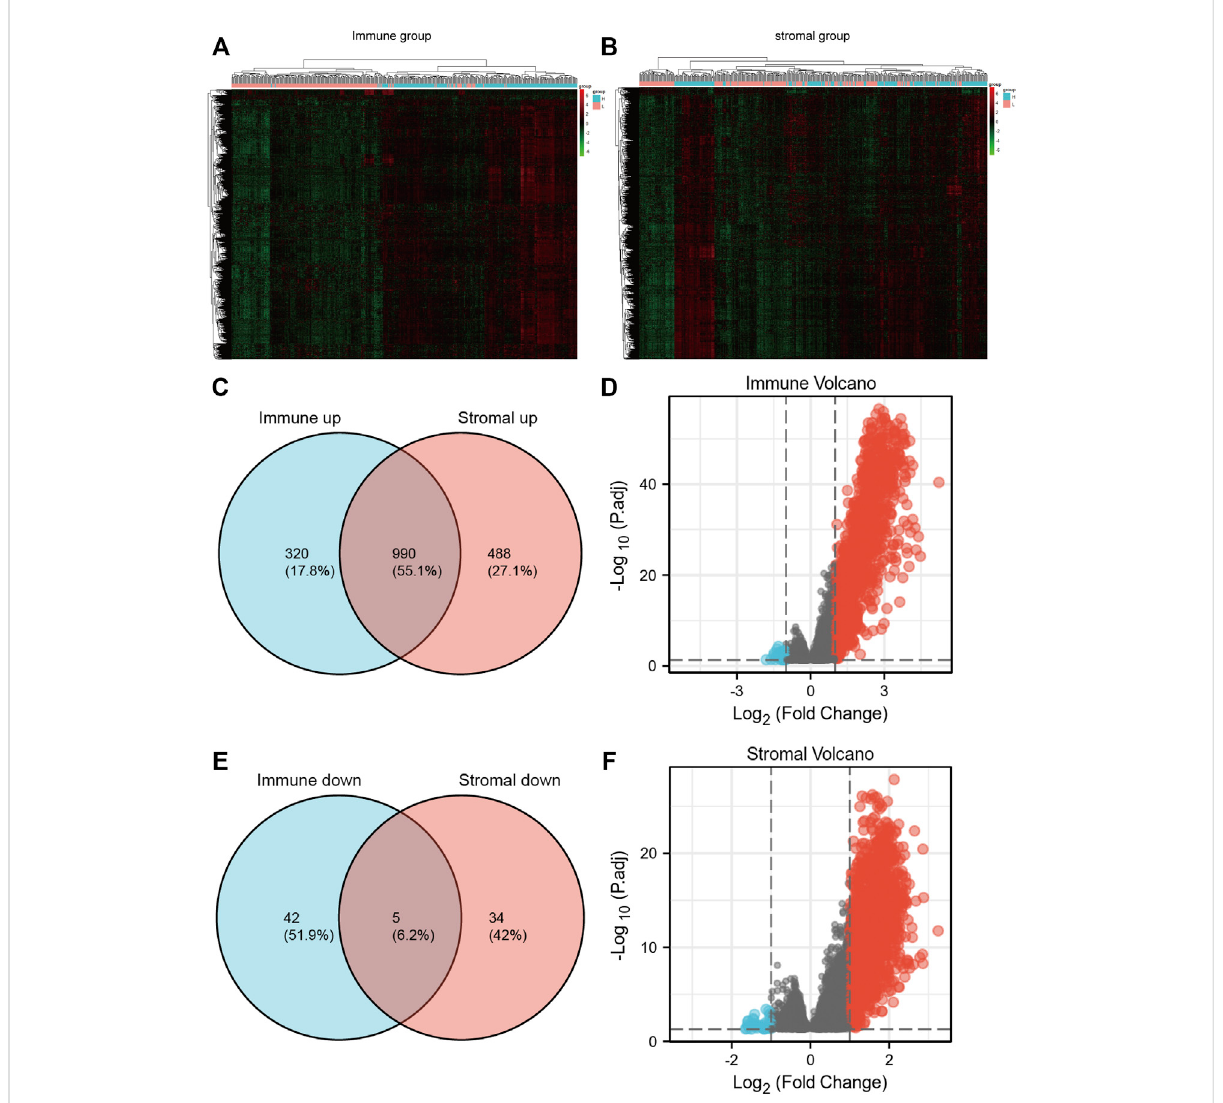
FIGURE 2 (A , B) heatmapsofgeneexpressionpro fi lesofsamplesbetweenhighimmune/stromalandlowimmune/stromalgroups. (C , D) theup-regulated and down-regulated overlapped DEGs. (E , F) volcano plot of immune and stromal